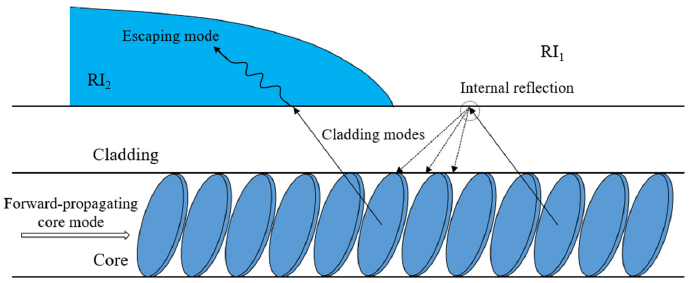
Figure 16. Schematic of a TFBG internal structure surrounded by two different RIs.